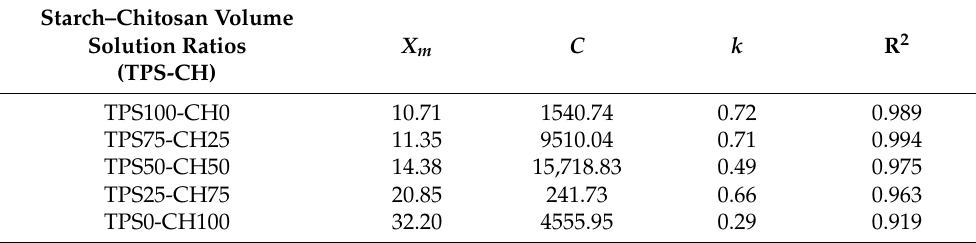
Table 3. Guggenheim–Anderson–de Boer (GAB) model parameters and regression coefficient, R 2 , calculated for biodegradable starch:chitosan